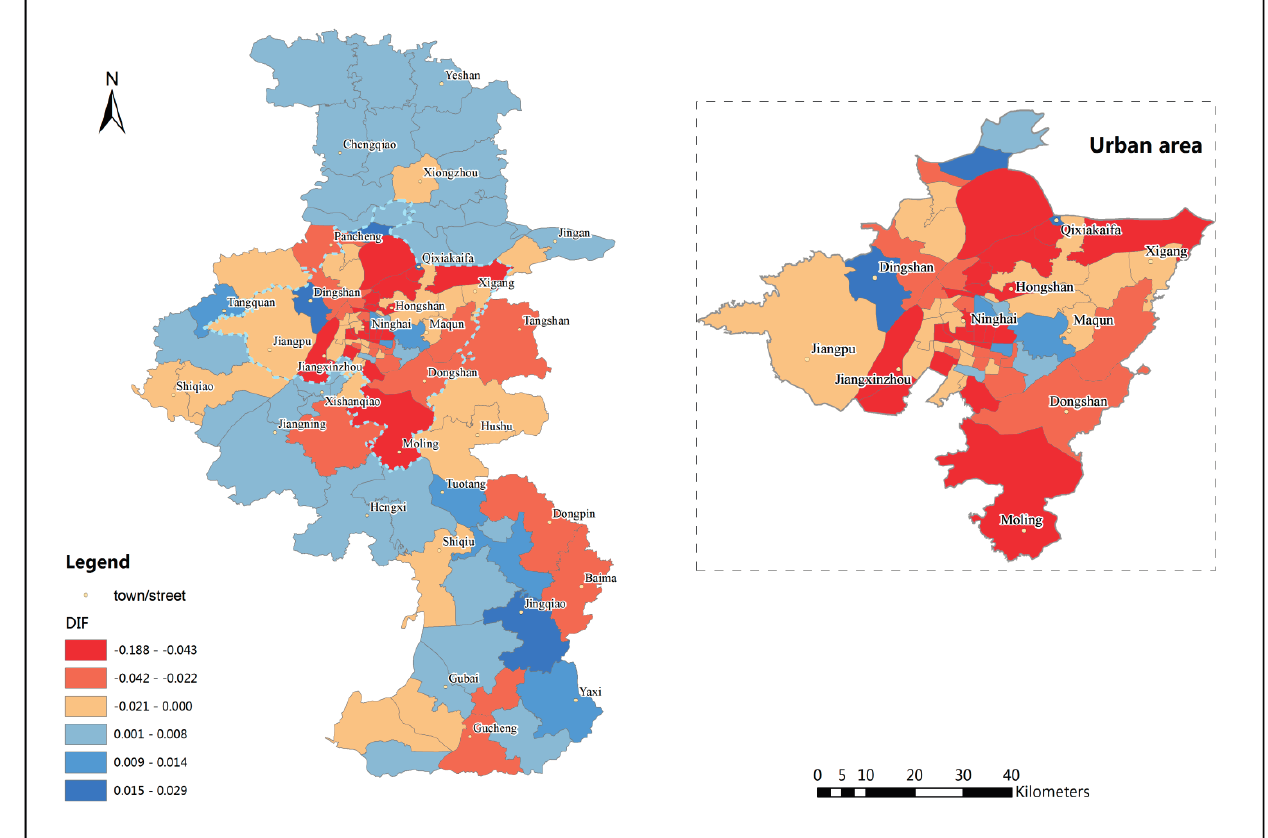
Figure 6. Spatial accessibility differences between EV2SFCA and V2SFCA